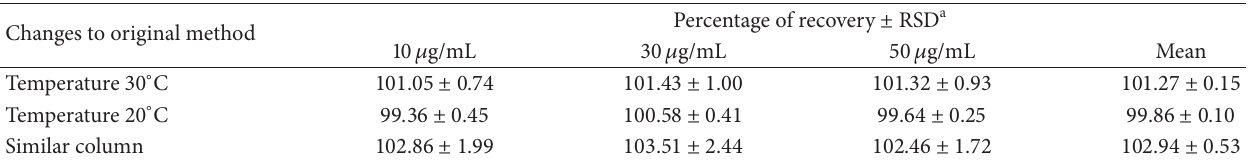
Table 3: Percentage of recovery and RSD obtained in the analysis of robustness after changes in original temperature of the method (25 ∘ C) and column mark ( 𝑛 = 3 ).